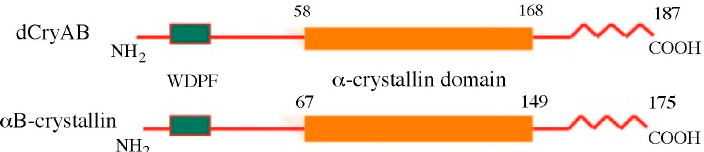
Figure 1. dCryAB as an example of heat shock protein (Hsp) protein domain organization conserved with human α B-crystallin. WDPF and α -crystallin domains are indicated. Numbers refer to amino acid positions.